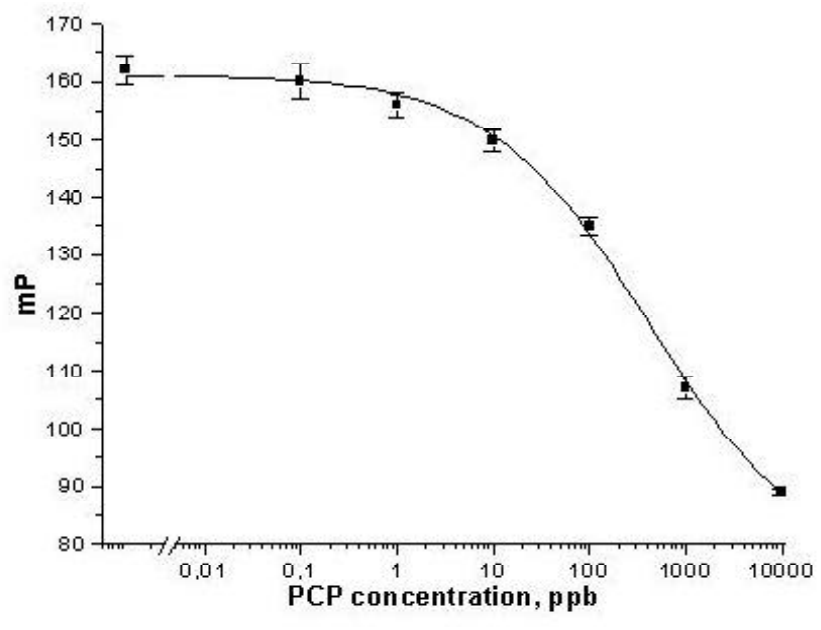
FIGURE 3 . PFIA calibration curve for PCP (serum anti-PCP-BSA, tracer PCP-O-CH